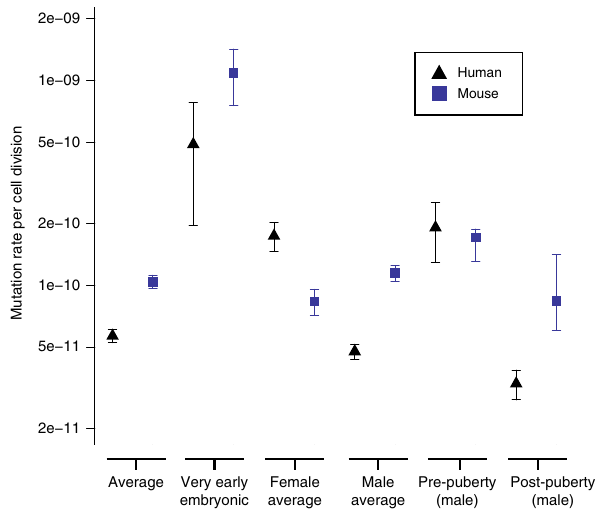
Fig. 5 Estimation of mutation rates per haploid base per cell division. Mean per-generation mutation rates for SNVs were calculated for mice and from humans using all the data from this study and Rahbari et al. 3 and Kong et al. 1 . The 95% con fi dence intervals were calculated assuming that DNMs are Poisson distributed, except for the pre- and post-puberty stages, which were derived from the linear models fi tted for the paternal age effects, and VEE mutations, which assume quasi-Poisson distribution to allow for over- dispersion. See ‘ Methods ’ for further information. The accuracy of the estimates shown here (aside from VEE mutations) rely upon the proposed cellular demographies by Drost and Lee